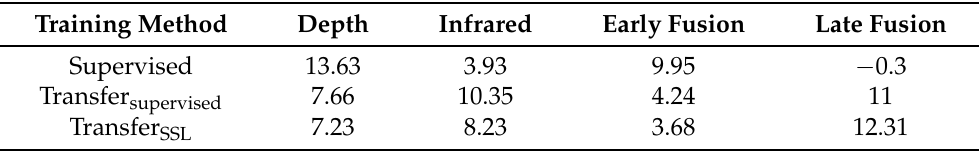
Table 4. Performance loss according to the amount of training data (unit: %).